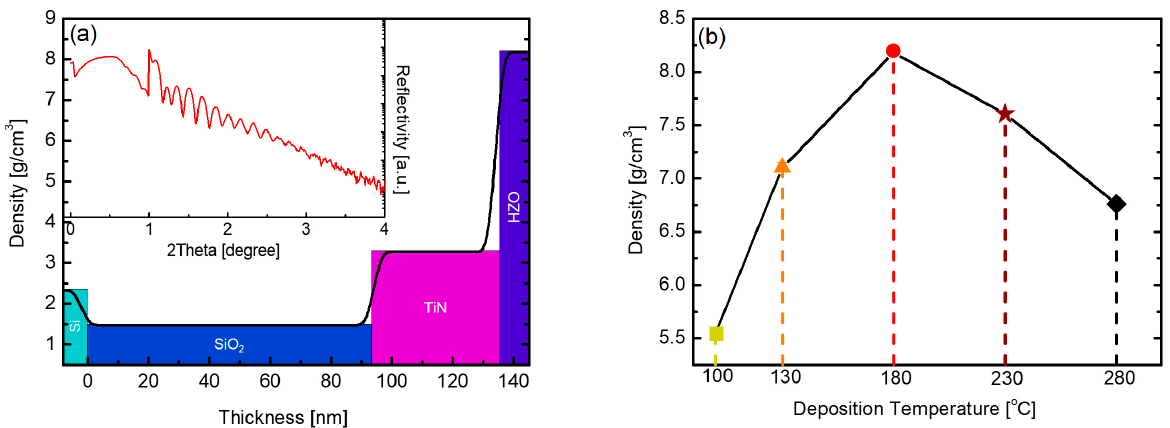
Figure 4. ( a ) XRR data of PEALD HZO thin film deposited at 180 °C and ( b ) HZO thin film density according to substrate temperature in the range of 100–280 °C.